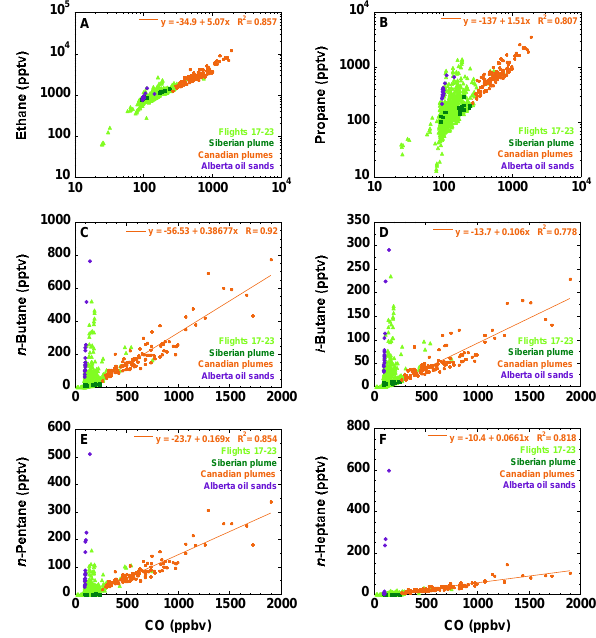
Figure 5. As in Figure 4 but for selected alkanes. Fig. 5. As in Fig. 4 but for selected